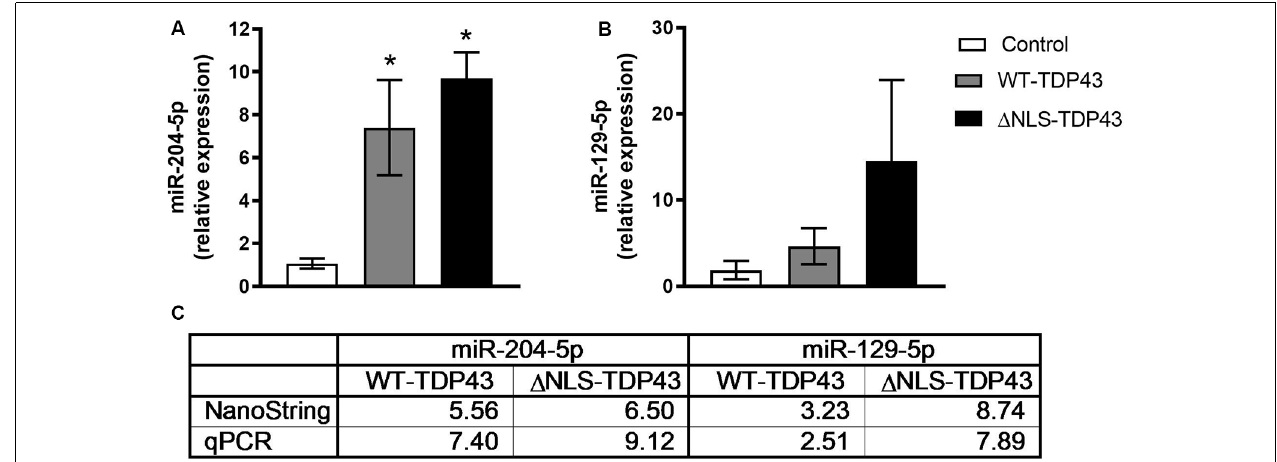
FIGURE 4 | Confirmation of select enriched miRNAs. Levels of select miRNAs from the NanoString profiling results in cytoplasmic fractions of the control (eGFP-His), WT-TDP43-eGFP-His (WT-TDP43), and ∆ NLS-TDP43-eGFP-His ( ∆ NLS-TDP43) lines were confirmed using quantitative real-time PCR (qPCR). Results were normalized to miR-92a ( ∆ CT) and then relative to the control group ( ∆∆ CT) and expressed as mean fold-change ± standard error of the mean (SEM; n = 4 per line). (A) miR-204-5p was significantly upregulated relative to control in both TDP43 lines in a similar proportion to the NanoString results (* p < 0.05). (B) miR-129-5p levels in both TDP43 lines were upregulated at fold-changes equivalent to the NanoString results, but did not reach significance relative to the control line. (C) Fold-change comparisons between the qPCR and NanoString profiling